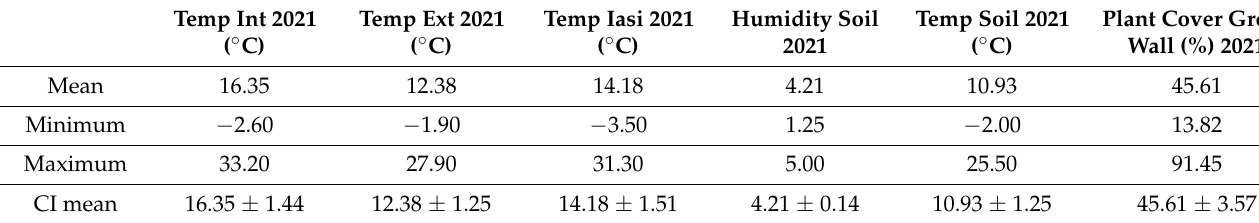
Table 2. Characteristics measured in